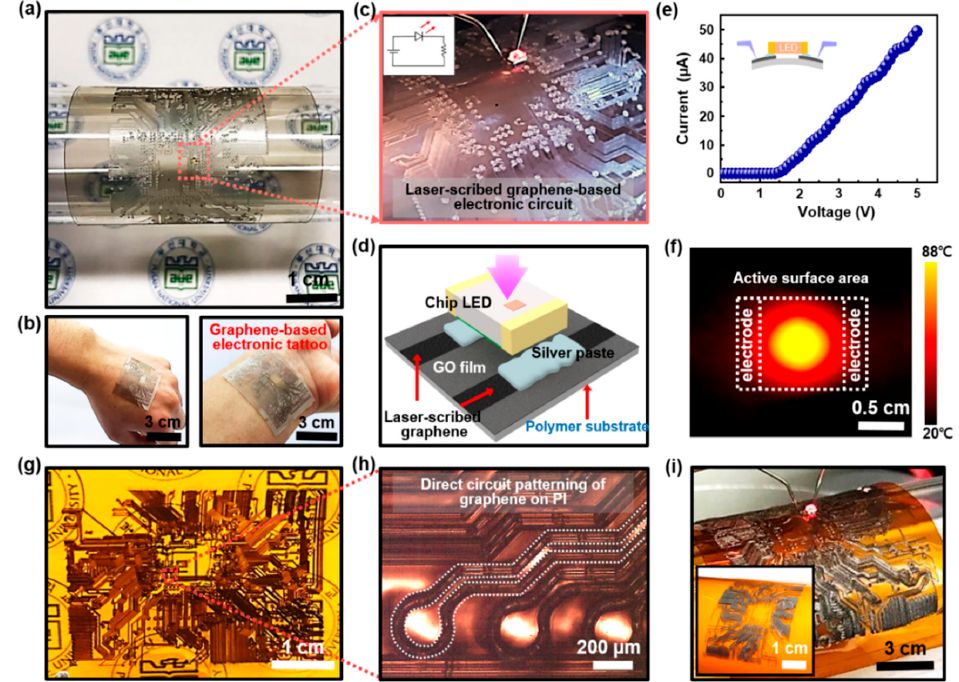
Figure 5. Graphene-based flexible electronic circuit boards produced via programmable direct laser-scribing. ( a ) Digital image of the representative flexible circuit board filled with the patterned rGO circuital lines, wrapped around a curved glass-tube surface. ( b ) Graphene-based electronic-tattoo attached on a wrist and back of a hand. ( c ) Light-up a surface-mounted LED integrated on an rGO-based circuit board in ( a ). ( d ) Schematic illustration of a chip LED bonded onto the isolated two terminal pads using silver-based solder paste. ( e ) Typical I-V characteristics of a chip LED integrated on the circuit board at bending state. ( f ) Thermographic image from a sticky plastic electronic tattoo (i.e., rGO-based microheater); thermal distribution ranged between 20 to 80 °C. ( g ) Digital image of the flexible circuit board prepared by direct laser-scribing of Kapton film. ( h ) Magnified OM image of a discretely patterned surface on the Kapton film; the white dotted lines indicate the laser-scribed conductive circuital lines. ( i ) Light-up a surface-mounted LED integrated on the two-terminal rGO circuit pads embedded on Kapton film.